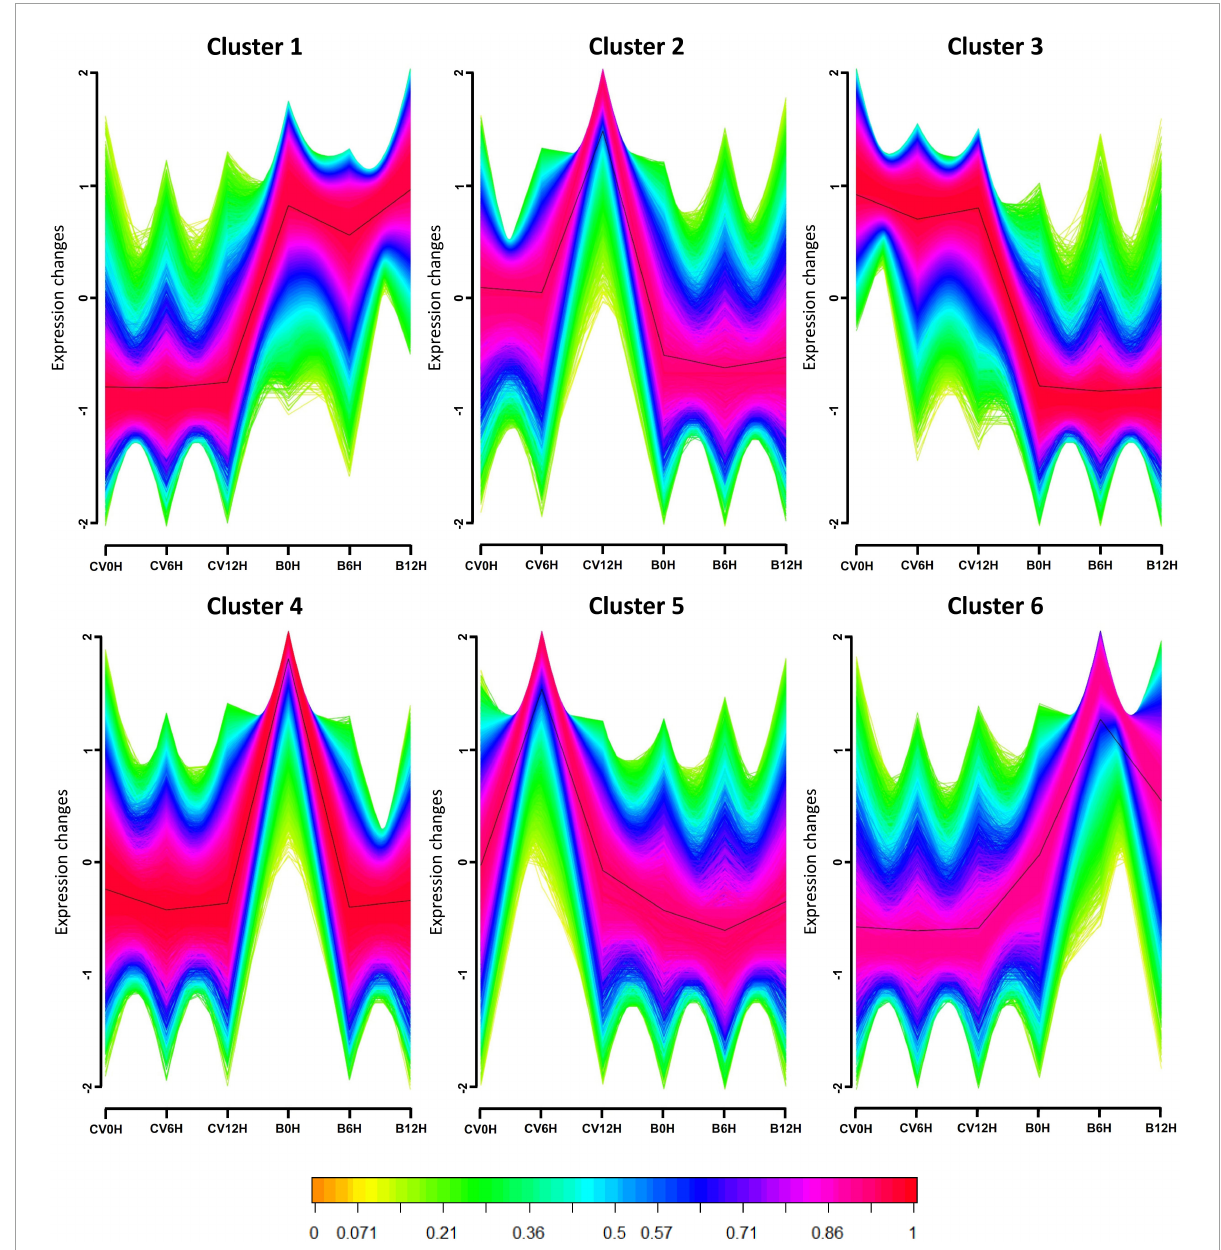
FIGURE3 Time-based gene cluster analysis indicates the genes displaying alike expression patterns among different treatments (VF and AVF Asia II 7 and MEAM1 whiteflies) were grouped into different clusters. The horizontal axis denotes acquisition access time while the vertical axis represents the changes in gene expression. Normalized and transformed gene expression data were subjected to fuzzy c- means (FCM) clustering algorithm. A membership value in the range of 0-1 was used for clustering. Green and yellow lines denote the genes with a low membership value. The clustering cores composed of genes with membership value ≥ 0.90 are colored pink and